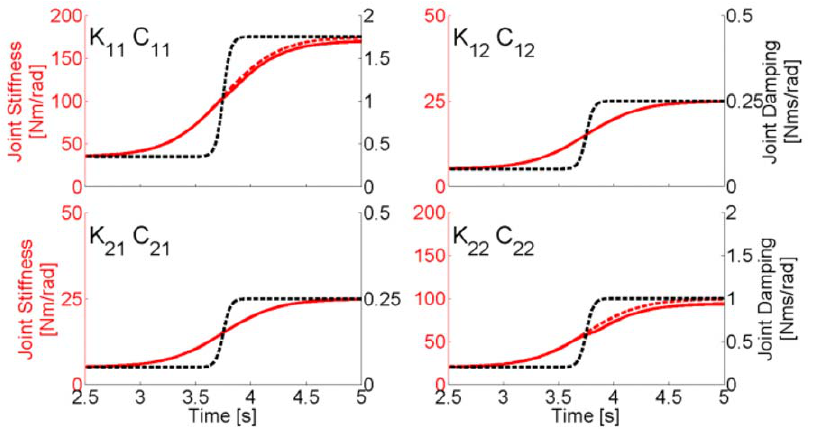
Figure 9. Effect of neglecting damping on stiffness estimation. Dashed lines represent the imposed stiffness (red), and damping (black) time- profiles, in accordance with the color-code of Figure 3. The solid lines represent the estimated values of stiffness coefficients when the natural frequencies of the system g j are assumed equal to the resonant frequencies v j therefore neglecting the damping contributions a j in equation (46).